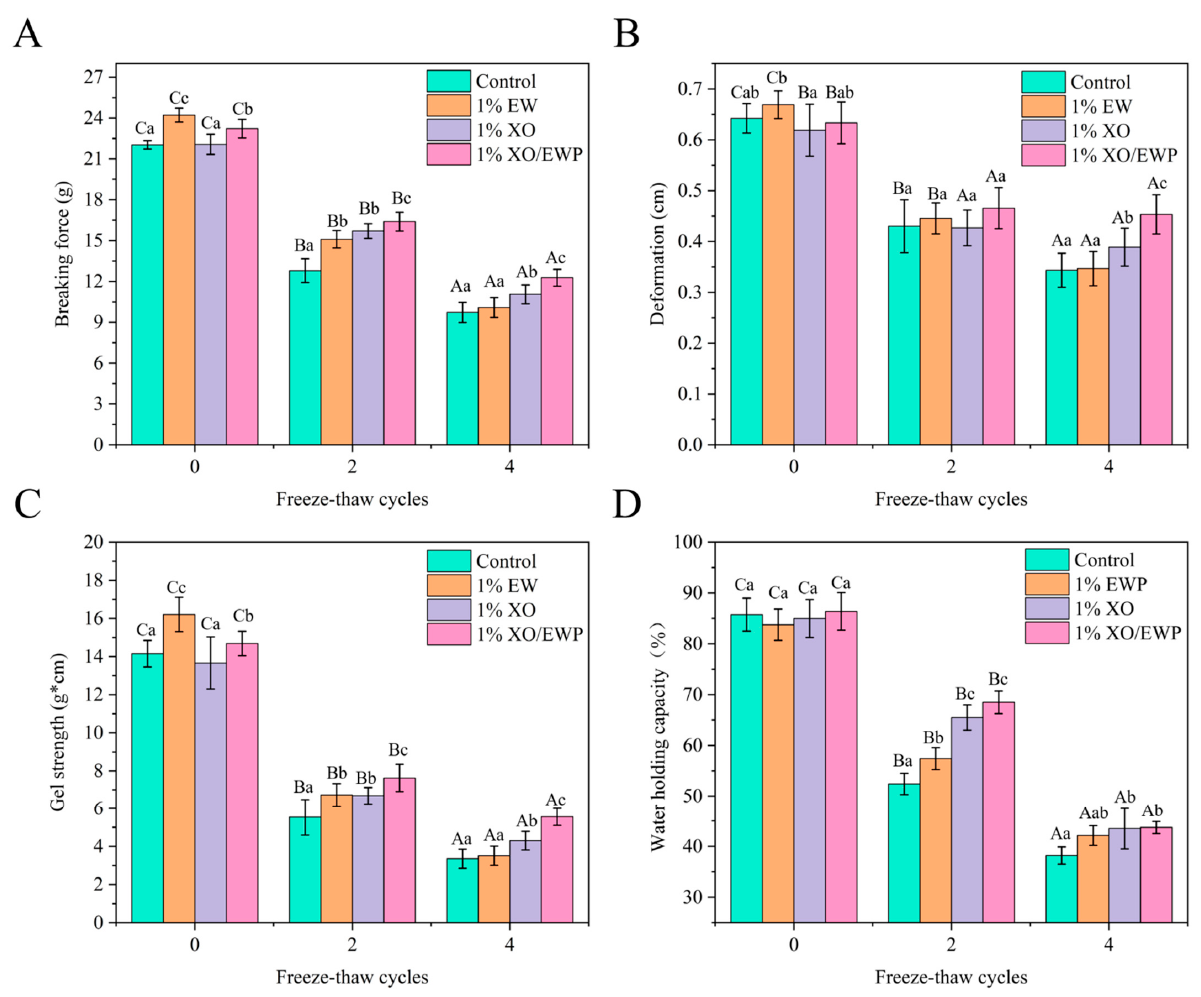
Figure 3. Changes of breaking force ( A ), deformation ( B ), gel strength ( C ), and water-holding capacity ( D ) in the heat- induced gel of Culter alburnus myofibrillar protein added with EW, OX, or XO/EW during freeze–thaw cycles (mean ± SD, n = 10). The control group (Control) was not added with EW, XO, or XO/EW. Capital letters indicate a significant difference ( p < 0.05) between the different freeze–thaw cycles within the same treatment group. Lowercase letters indicate a significant difference ( p < 0.05) between different treatment groups in the same freeze-thaw cycle.